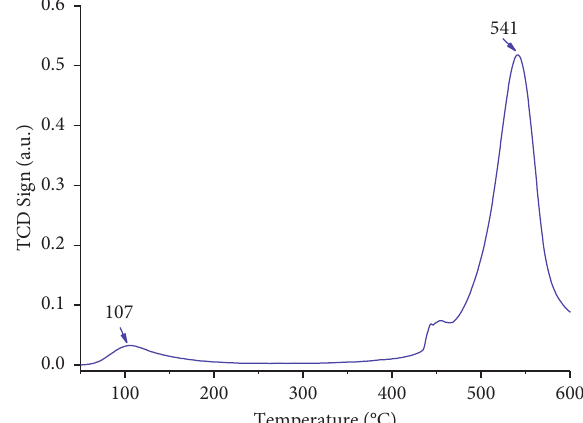
Figure 5: NH 3 -TPD of the HPW@CoCeO catalyst.